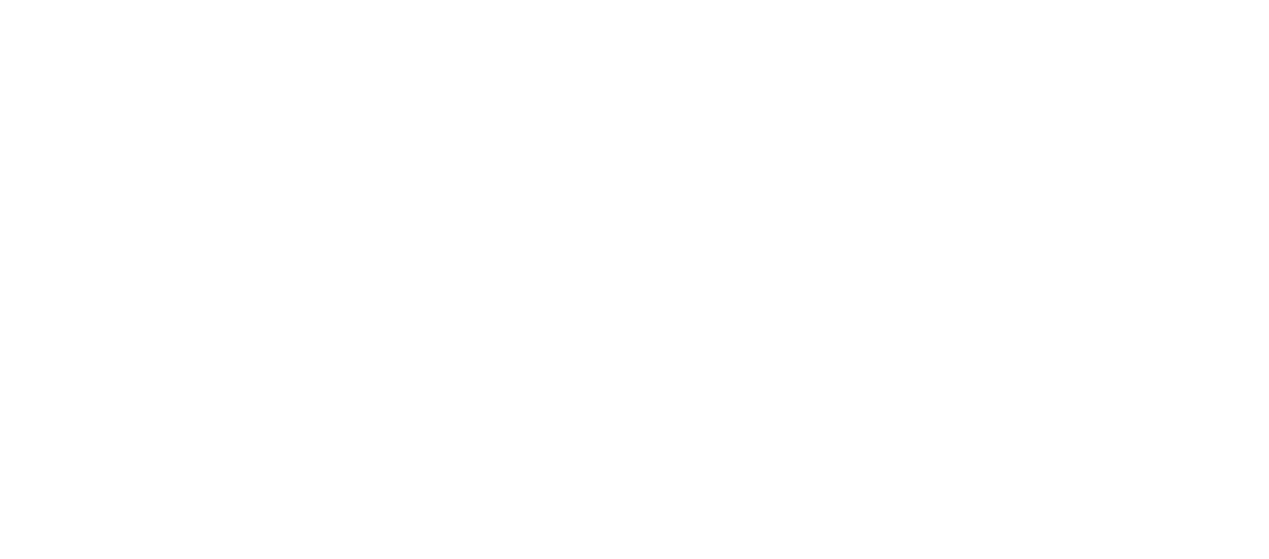
Frontiers in Veterinary Science |